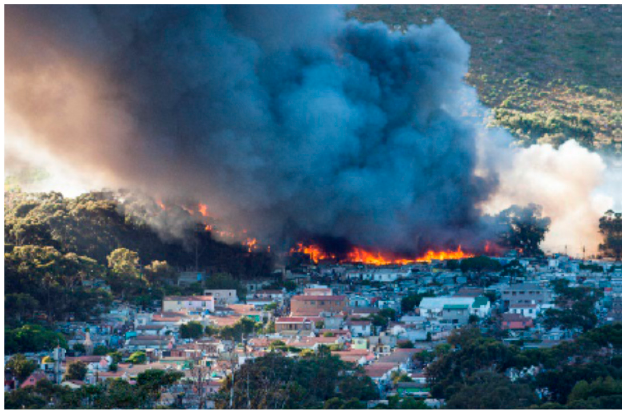
Figure 2. Imizamo Yethu informal settlement fire [4]. With permission from Ryan Heydenrych.